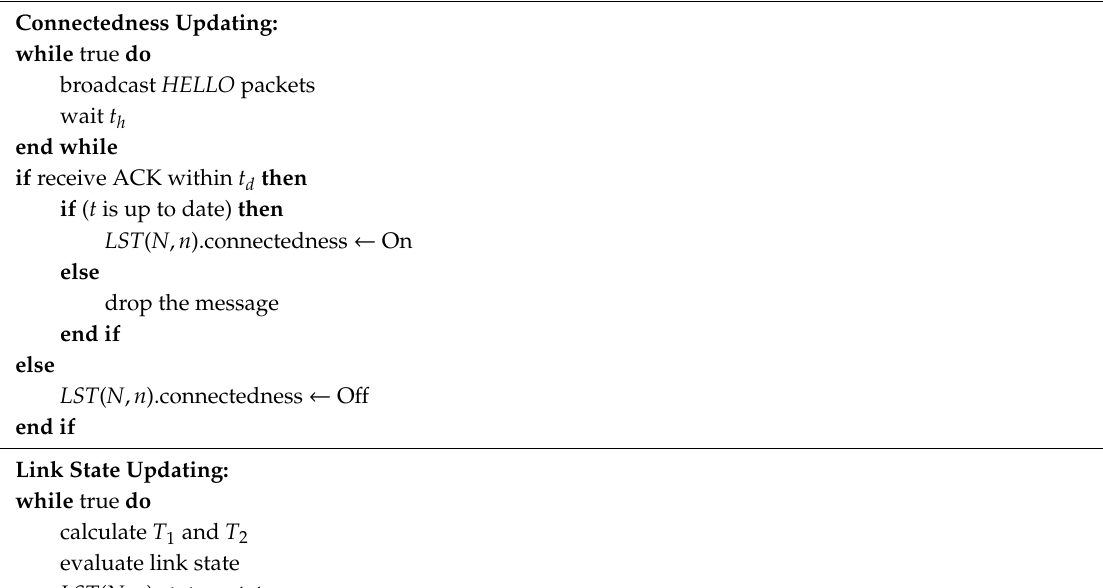
Algorithm 1 Dynamic Two-Hops State Aware